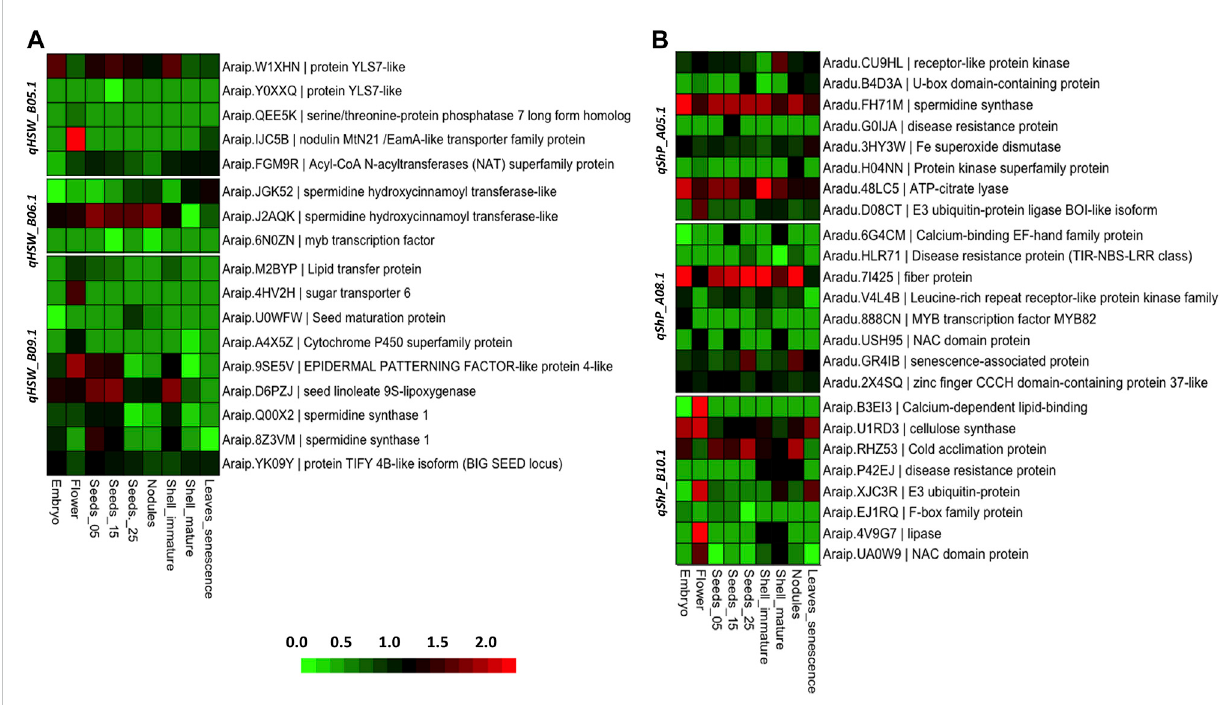
FIGURE 6 Heatmapillustratingtheexpressionofcandidategenesinvariousseedandpoddevelopmentstages. (A)